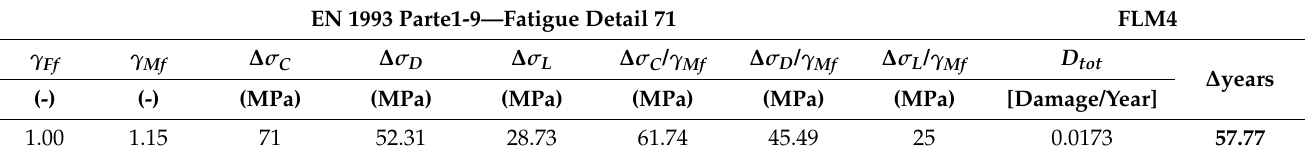
Table 9. Distinction of detail assessment: